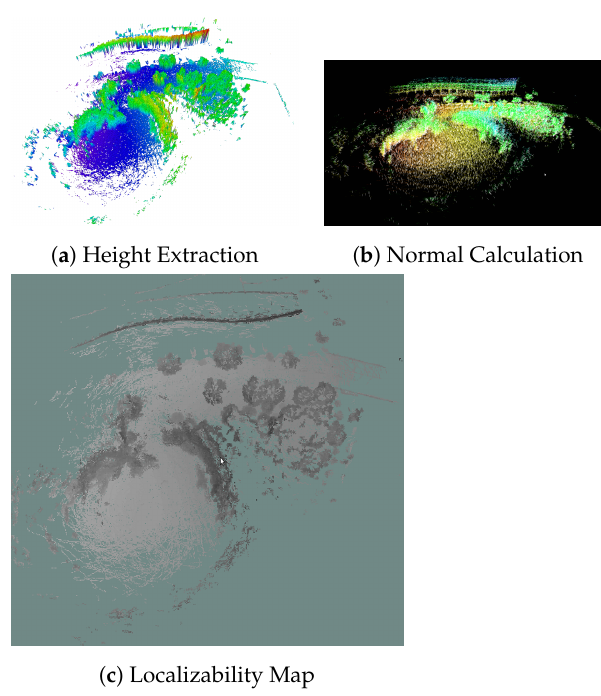
Figure 8. Results of Pre-Processing and Localizability Map.